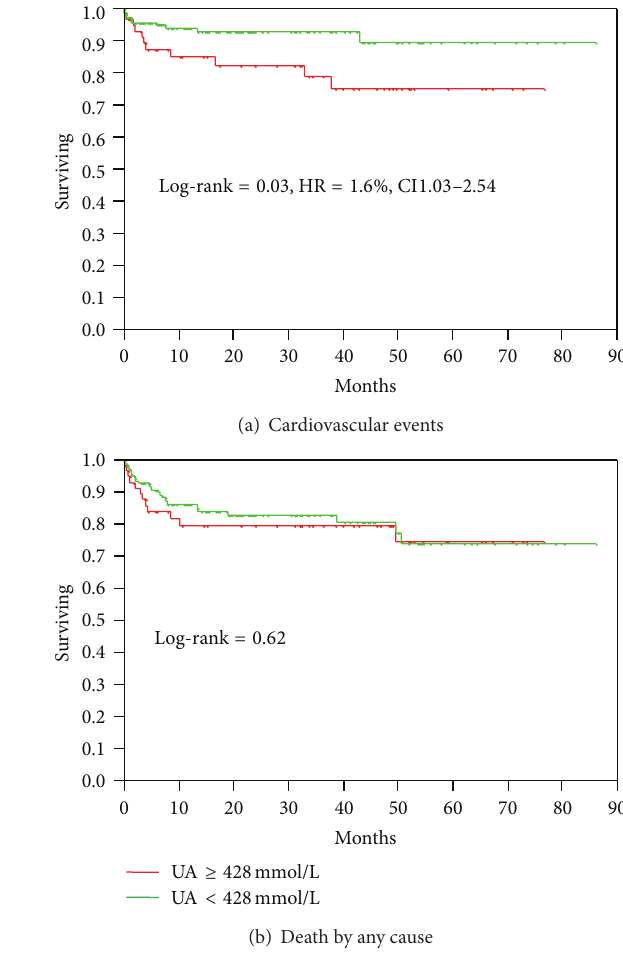
Figure 2: (a) and (b) Cardiovascular events and mortality in renal transplant patients according to uric acid